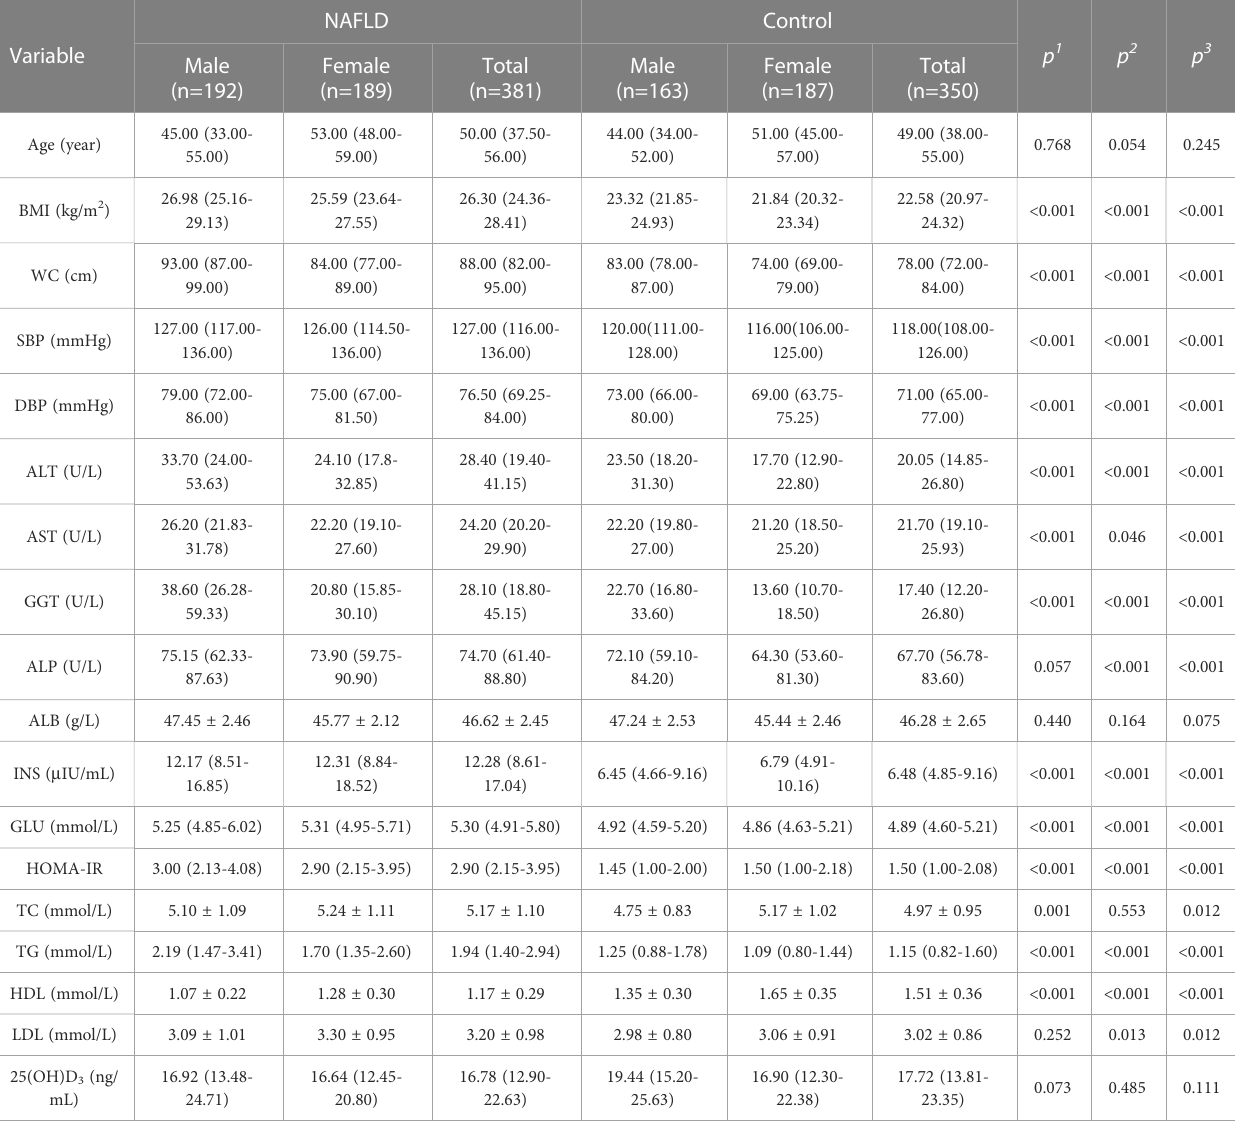
TABLE 1 Clinical and biological characteristics of NAFLD and